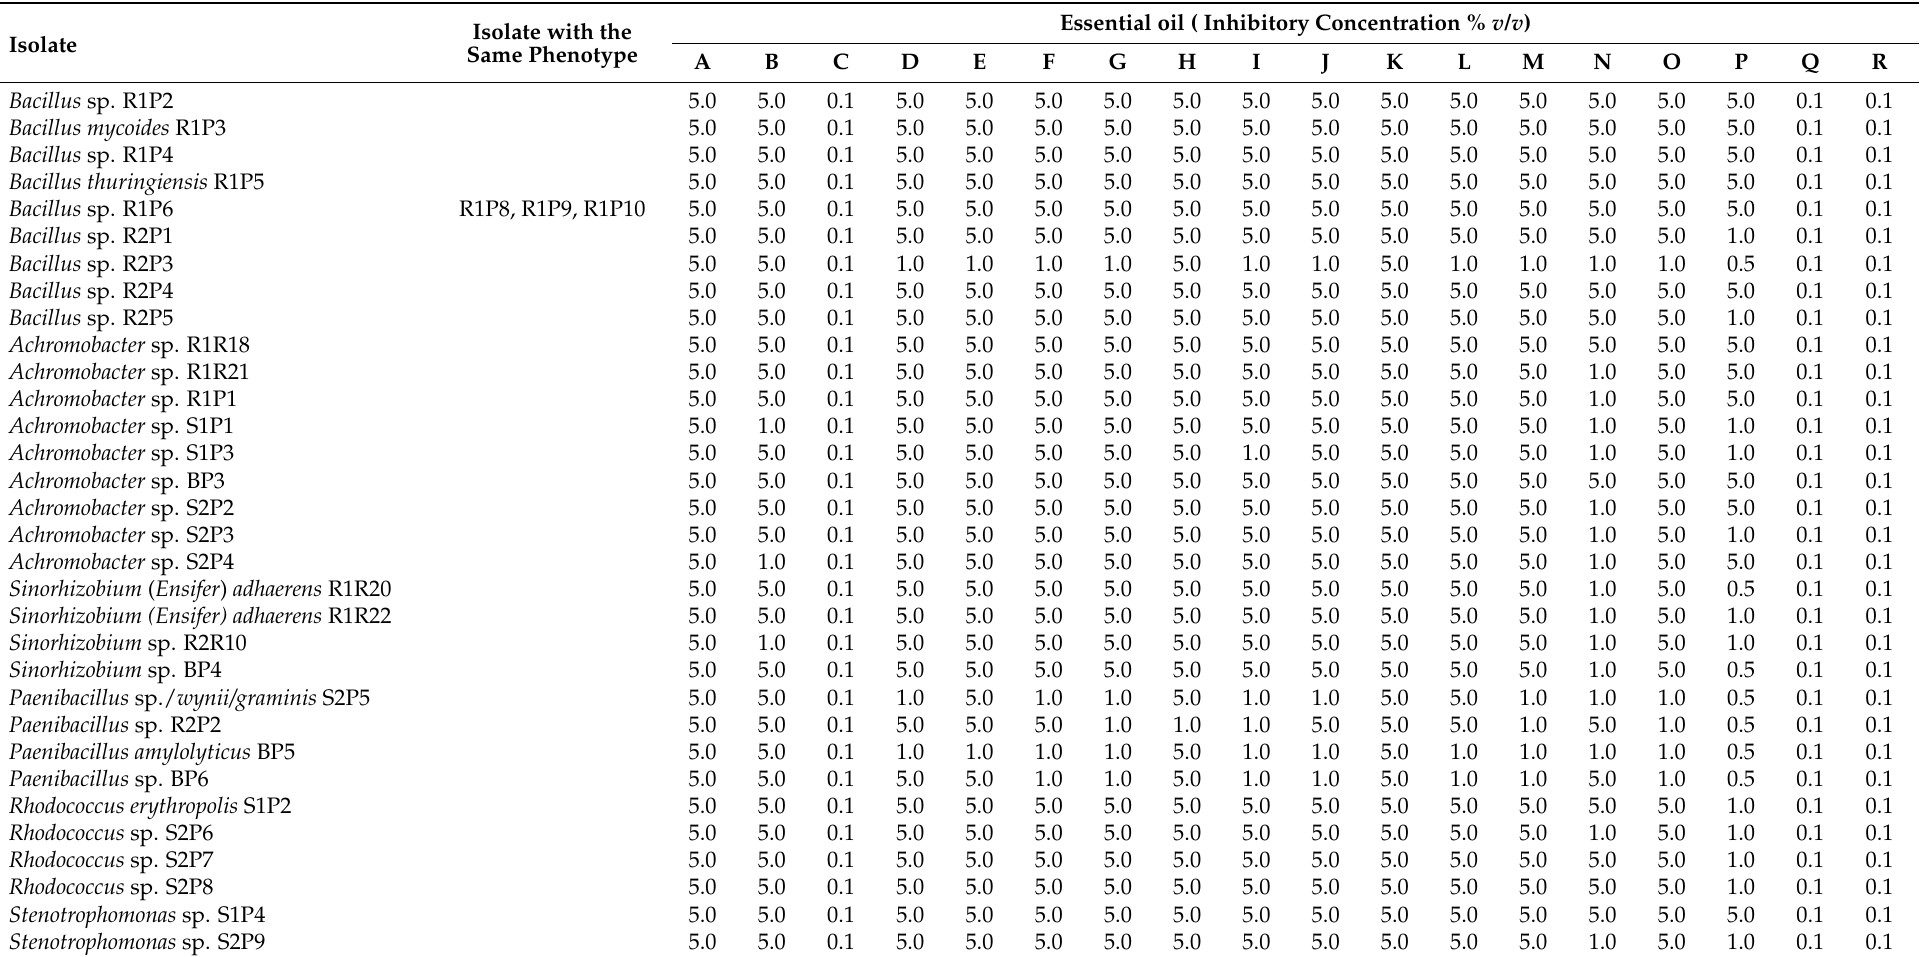
Table 2. Antimicrobial activity of the 18 EOs on the bacterial